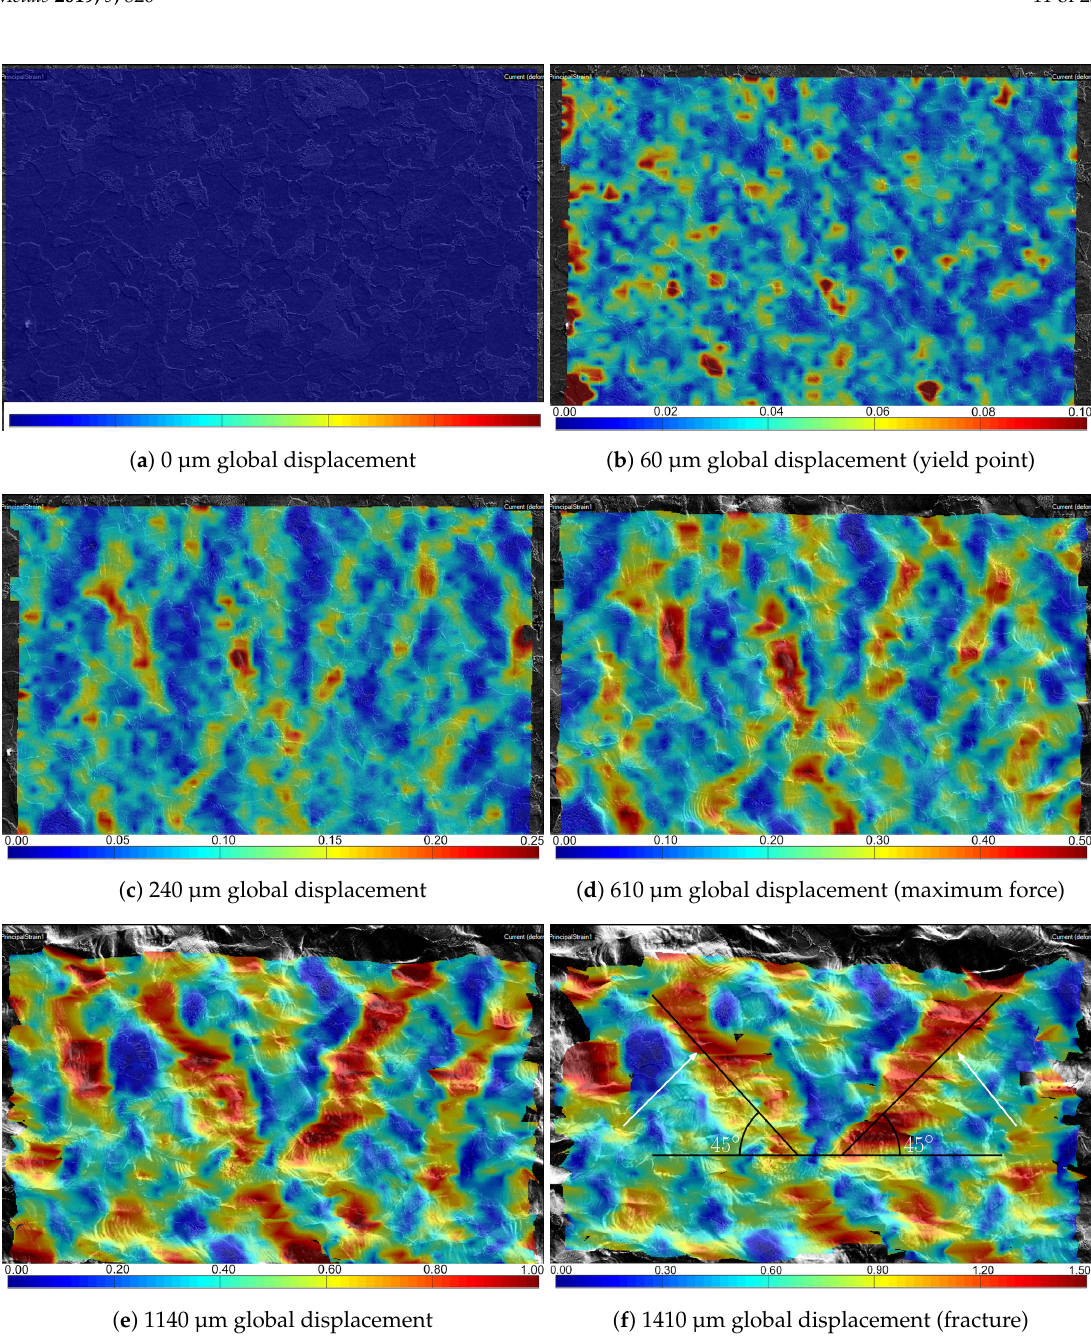
Figure 8. Micrographs with the measured strain field superimposed at different global displacements in the notched specimen. ( a – f ) The strain maps relate to the force–displacement curve in Figure 6. The white arrows in ( f ) indicate the deformation bands discussed in Figure 9. In all frames, the pulling direction in the in situ SEM tensile test is from right to left. Each frame has the same dimension, 160 µm × 108 µm. The fringe colors give values of the major principle